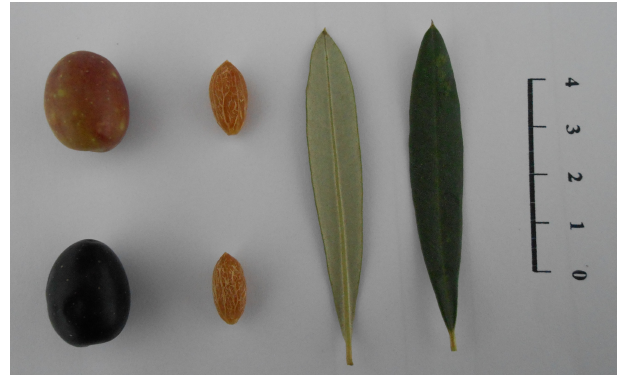
Figure 1. Leaf, fruit and endocarp of ‘Zeitoun Ennour’ olive cultivar. Scale in